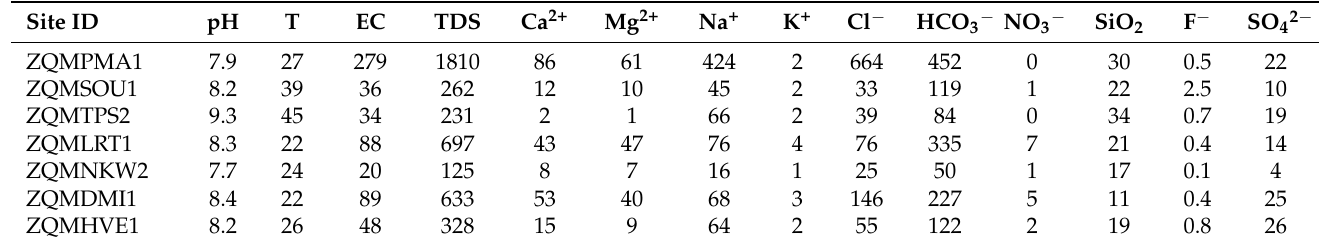
Figure 4. Spatial distribution of fluoride in the Soutpansberg region. Table 1. Physico-chemical results of each monitoring site in the Soutpansberg